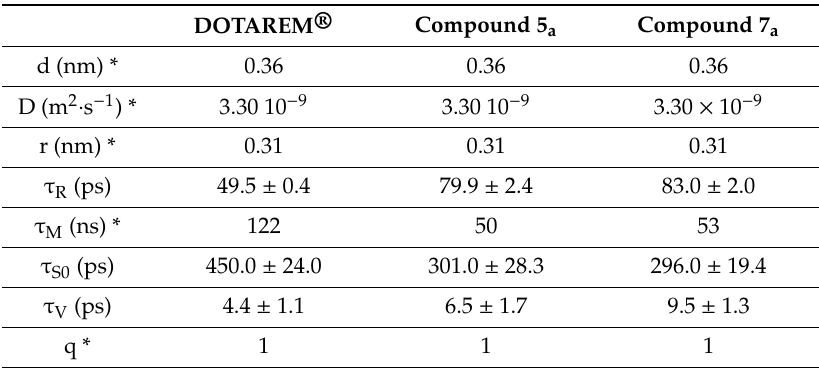
Table 1. Parameters extracted from the NMRD profiles fitted according to the Solomon and Bloembergen theory.